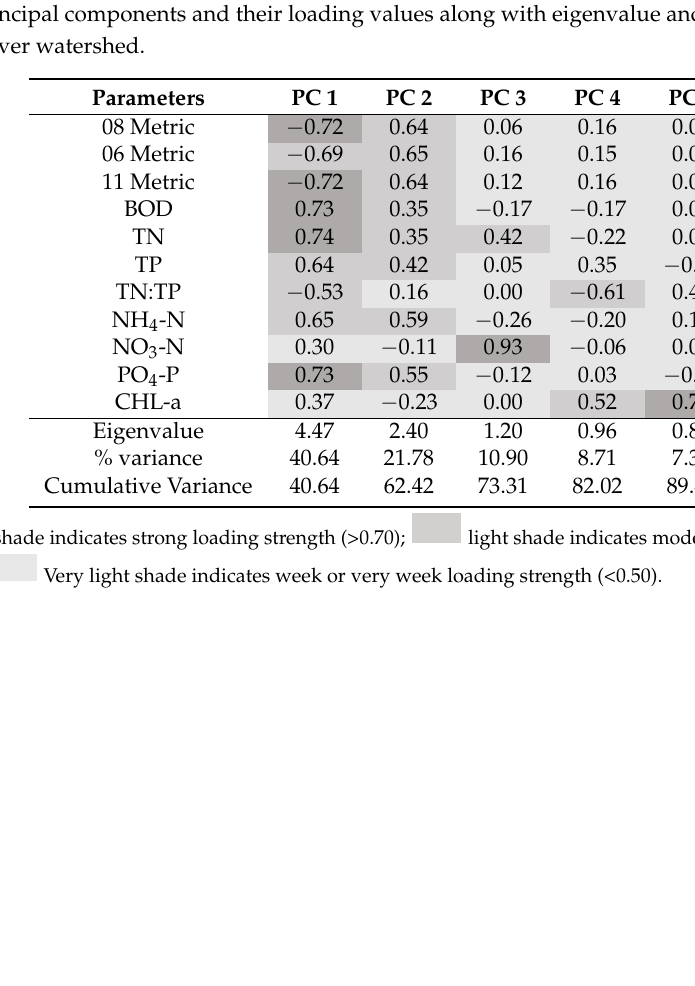
Table 9. Principal components and their loading values along with eigenvalue and percent variances in Guem River watershed.